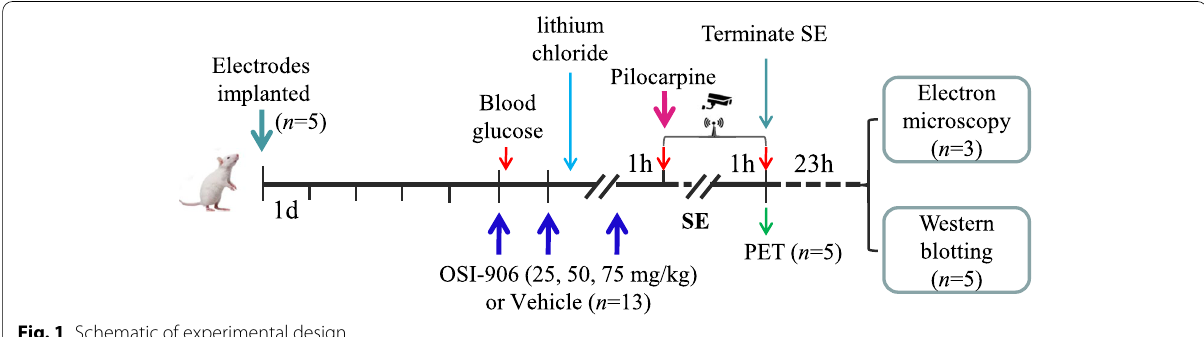
Fig. 1 Schematic of experimental